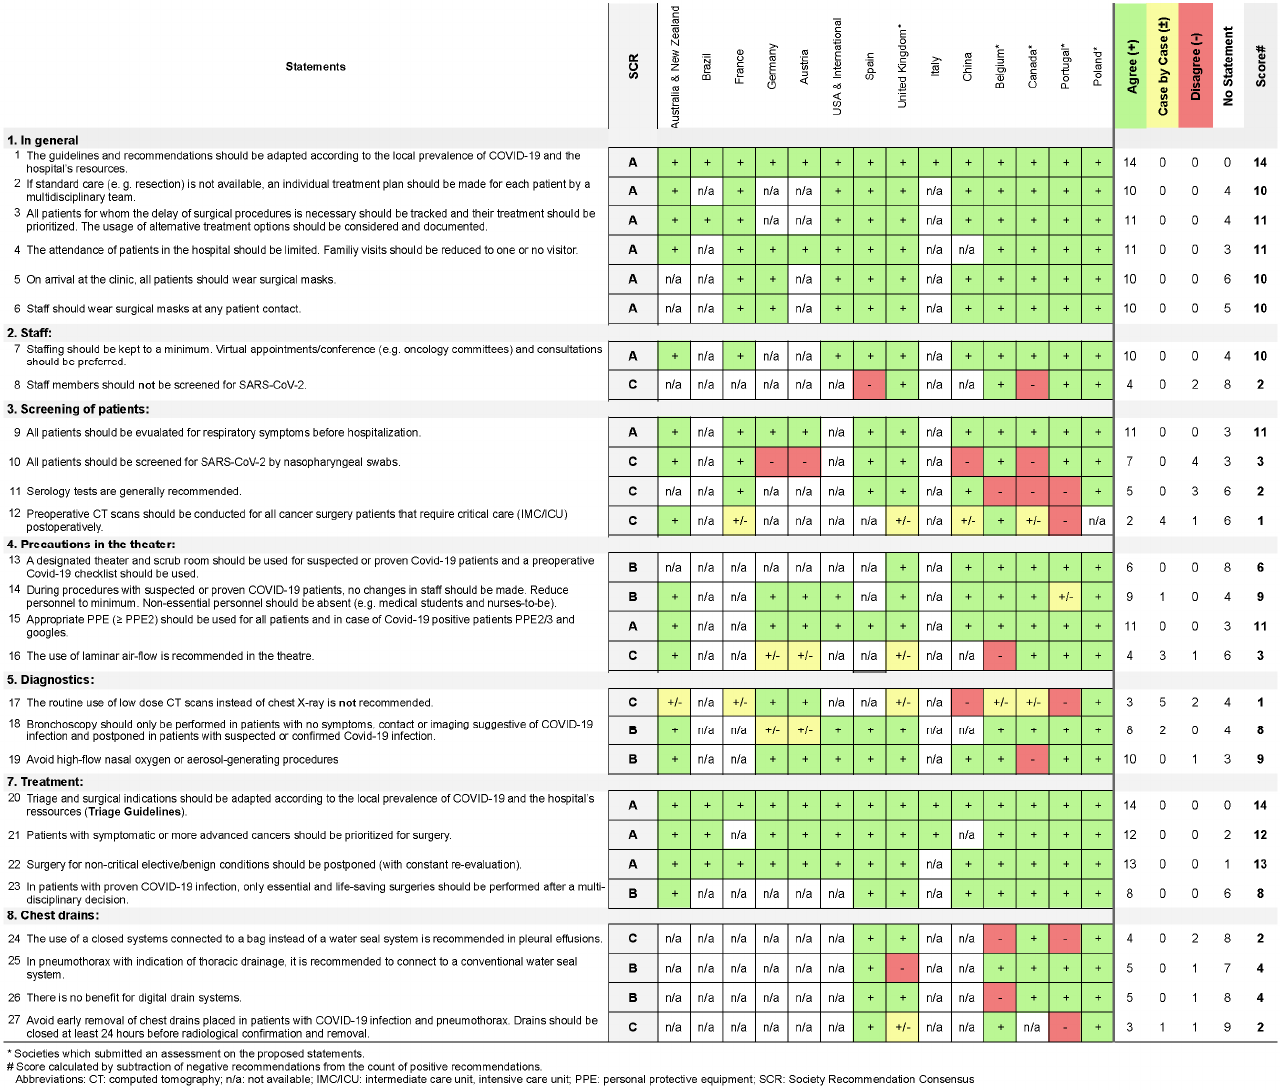
Figure 1. Proposed statements and SRC classification.